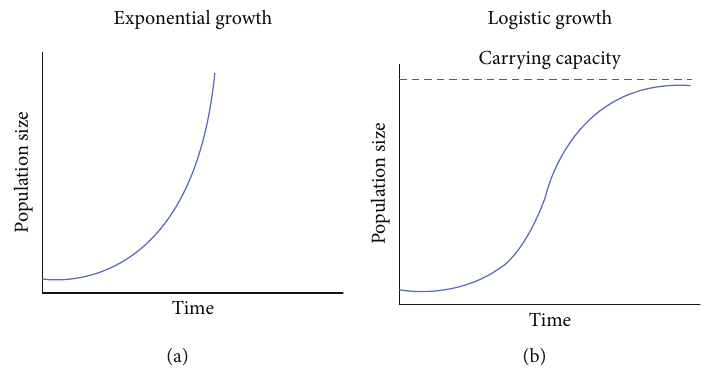
Figure 1: Logistic function: (a) exponential growth and (b) logistic growth. Table 2: Statistical analysis of the proposed system for Australia.